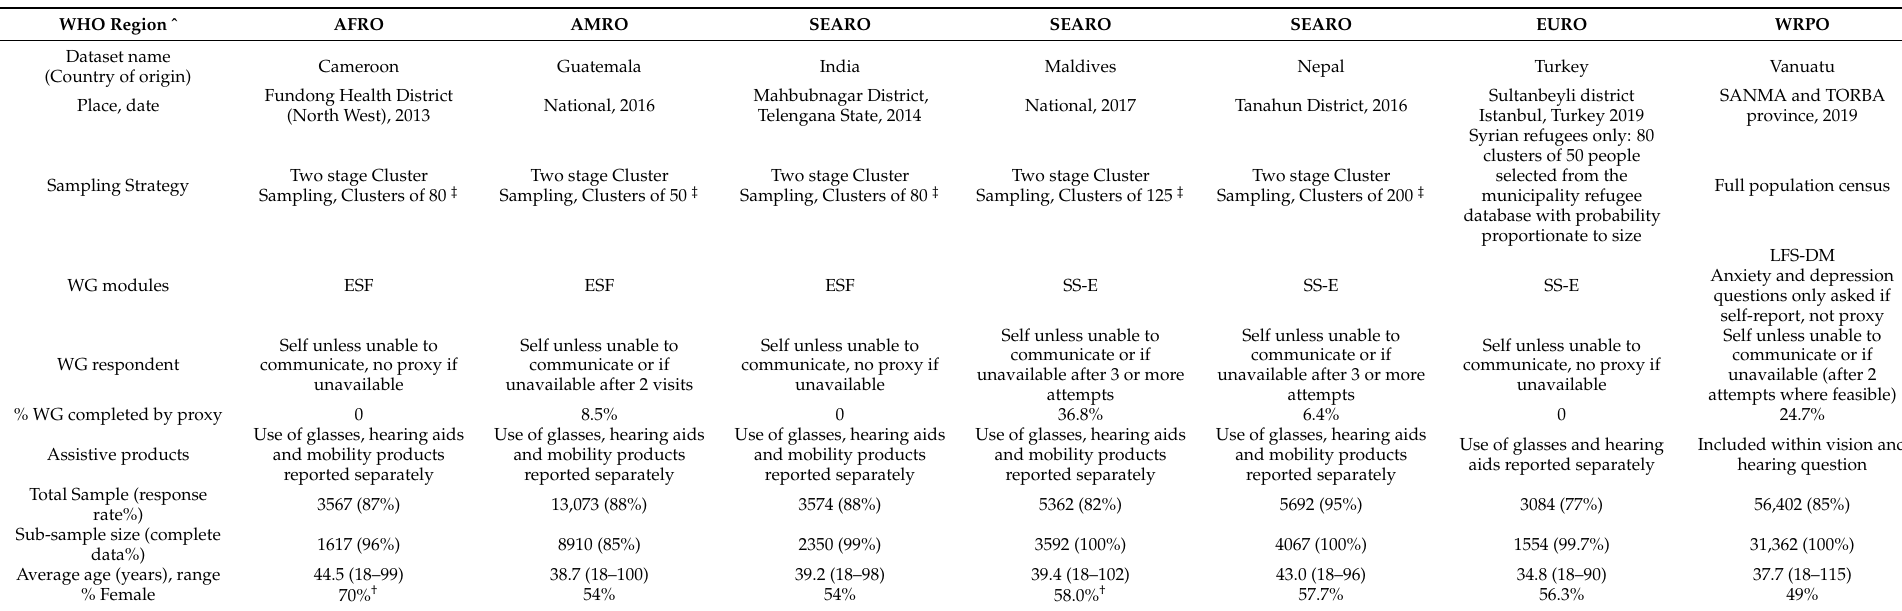
Table 2. Data sources